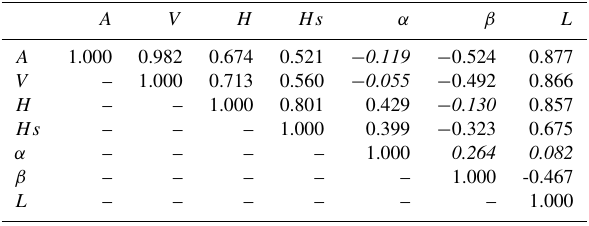
Table 3. Correlation coefficients of continuous variables listed in Table